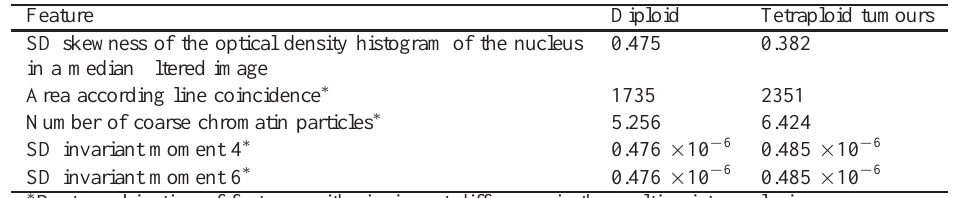
Table 5 Significant different features in p53 positive nuclei of the diploid and tetraploid tumours ( p < 0 . 05)